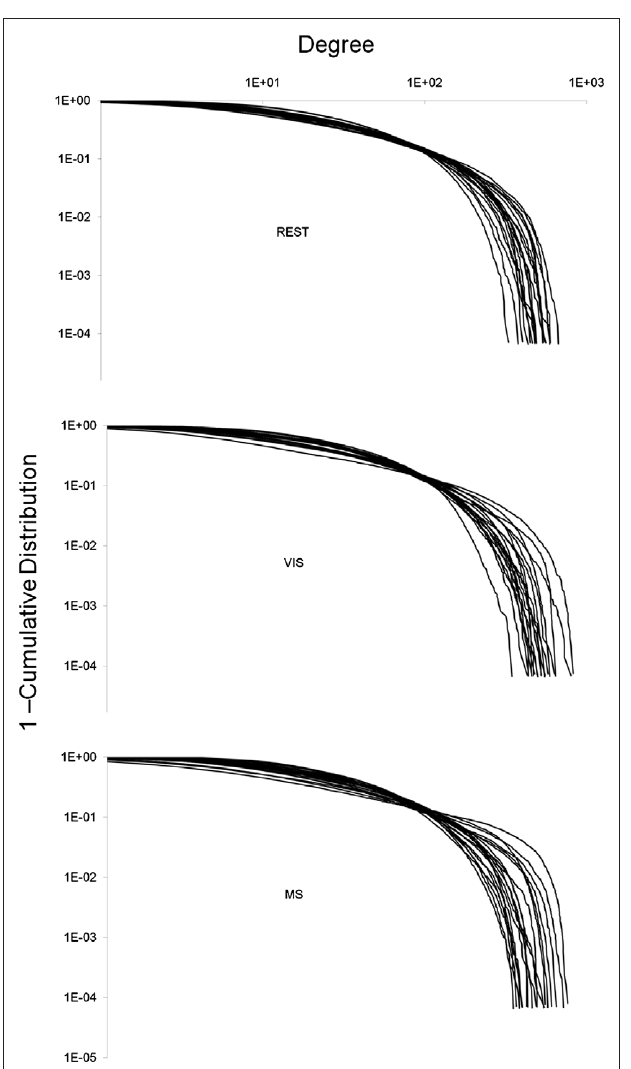
Figure 4 | Whole-brain degree distributions. The degree of each node in a network was plotted against one minus the cumulative distribution. This was done for each individual in all three tasks: rest (REST), visual (VIS), and multisensory (MS). In all three cases, the degree distribution followed an exponentially truncated power law. No obvious differences between the tasks were observed.